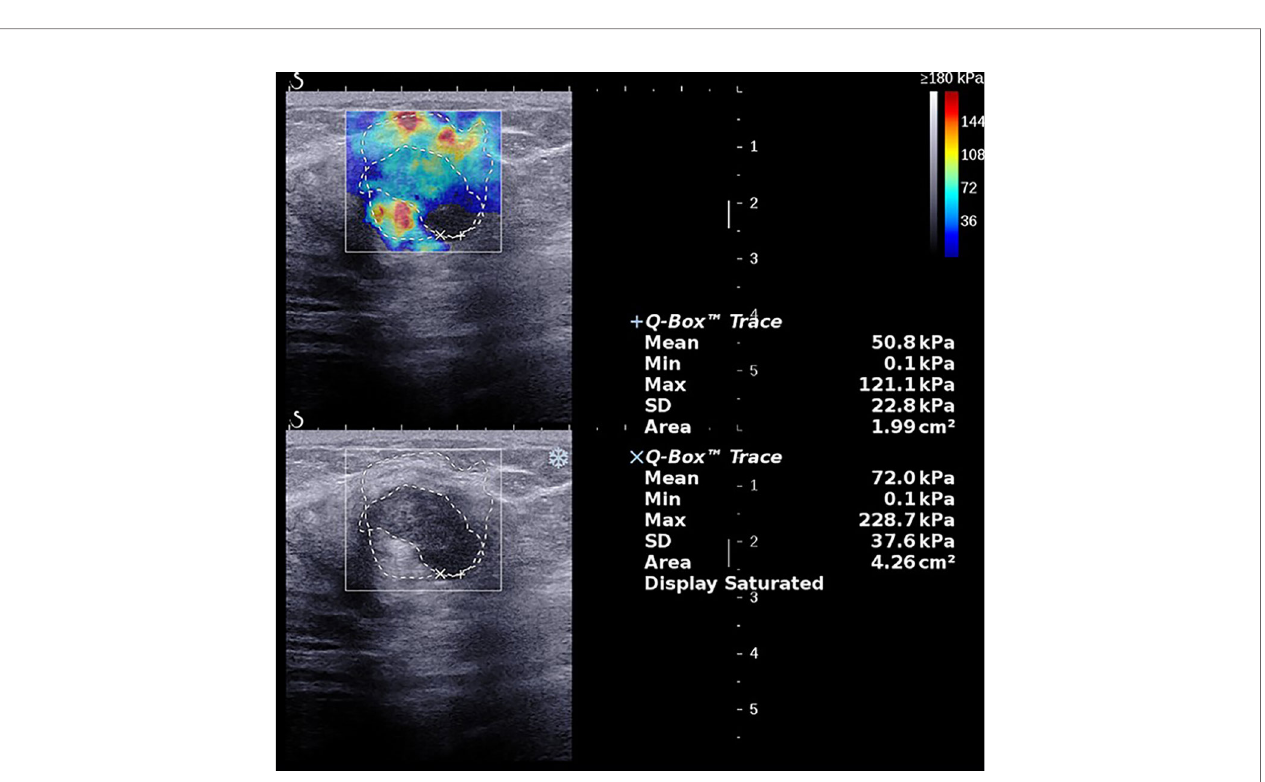
FIGURE 3 | A 62-year-old female with a 28.0-mm lesion in the left breast. The SWE parameter values of the cancer were as follows: E max , 236.0 kPa; E mean , 69.3 kPa; SD, 41.5 kPa; AR, 2.02. The lesion was invasive ductal carcinoma with the histological grade III, showing negative lymphovascular invasion and negative axillary lymph node status, ER - and PR - , HER2 - , and high expression of Ki-67,